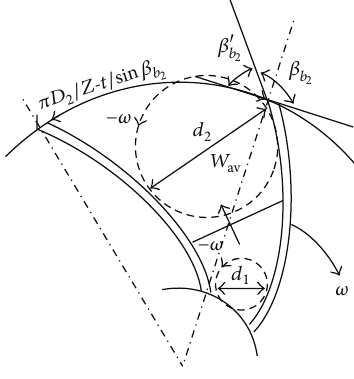
Figure 3: Flow model for Stodola slip